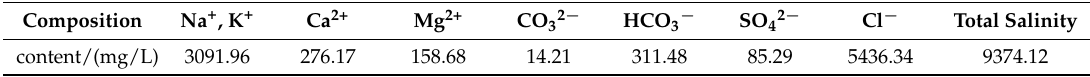
Table 2. The composition of synthetic brine.